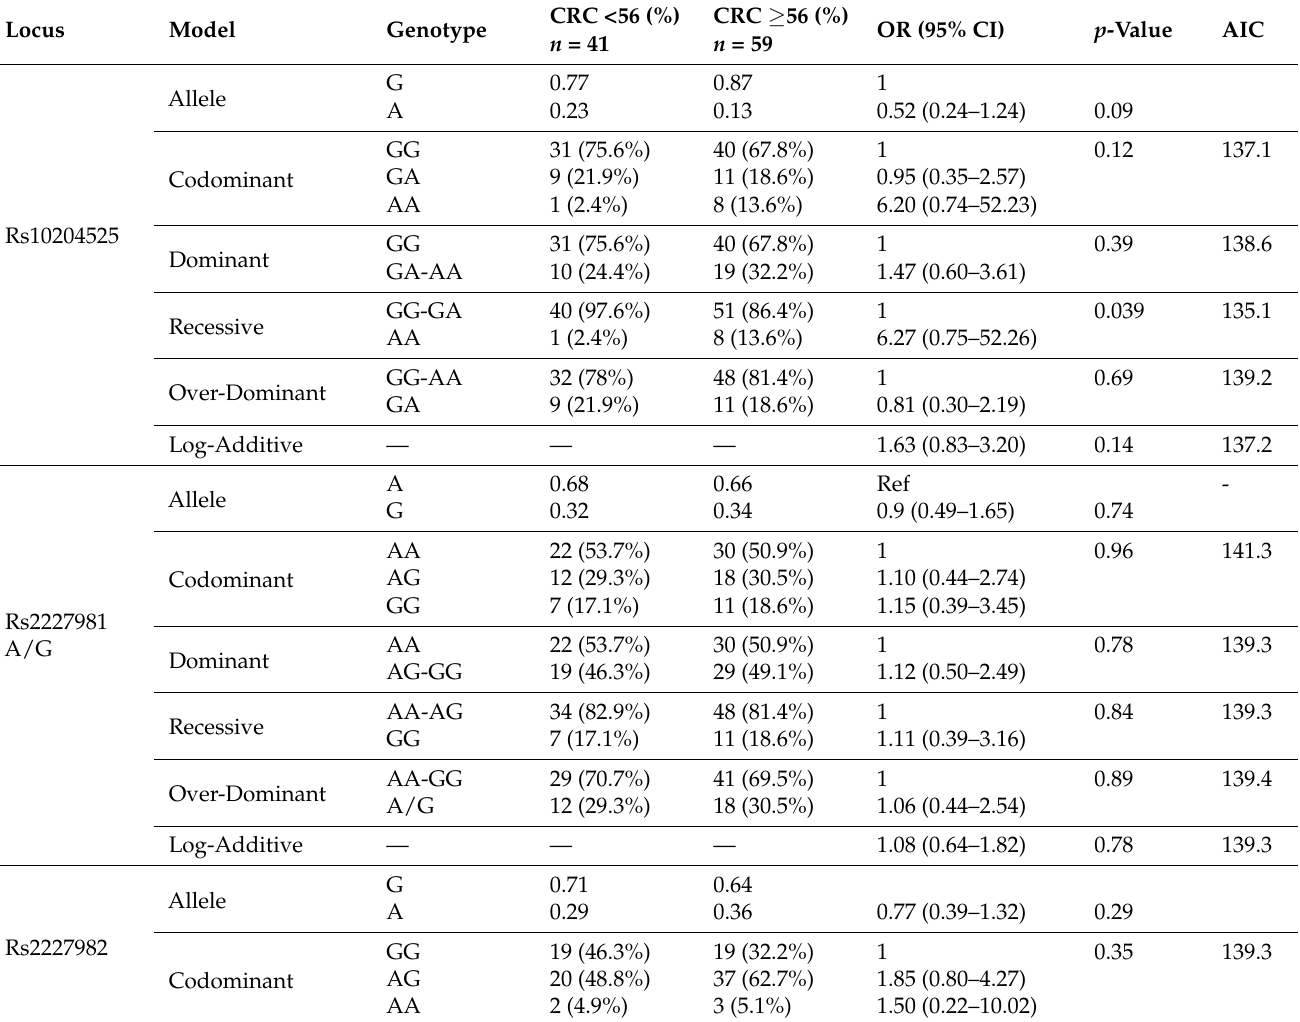
Table 4. Association of PD-1 SNP polymorphisms with CRC after age